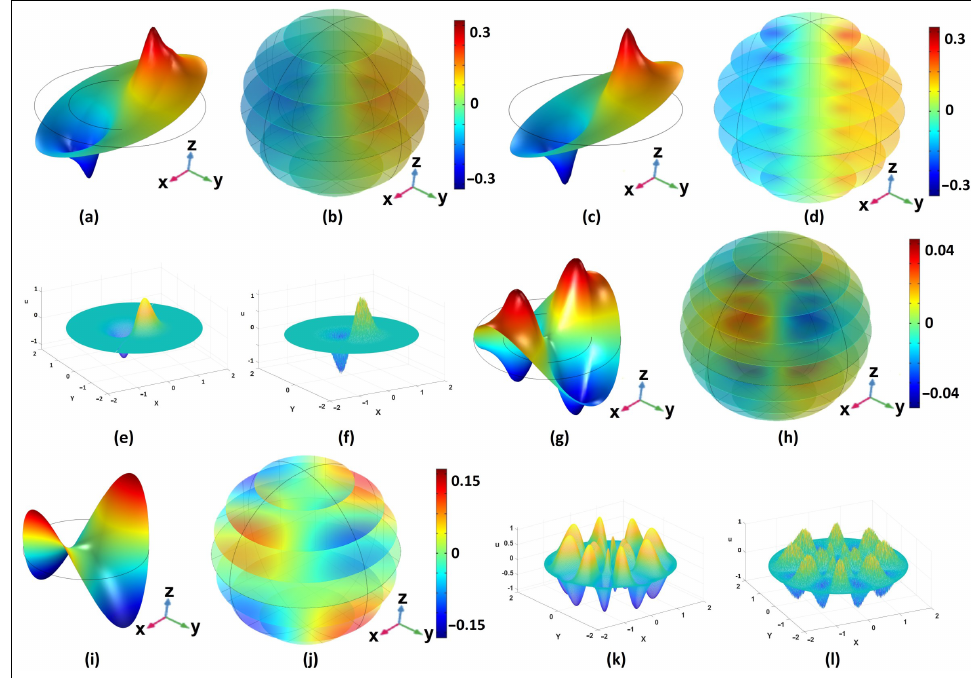
Figure 6. Solution of the problem described in Equations (21) and (22) (simplified) for the 2D and 3D case for the dipolar source and ( x 2 − y 2 ) z , as well as the original boundary problem for two regions described in Equations (4)–(8). ( a – d ) solution of the boundary problem in the dipolar source; ( a , b ) two regions case; ( c , d ) simplified 2D and 3D regions case, respectively; ( e , f ) source and recovered solution from solving the inverse problem; ( g – j ) solution of the boundary problem of the source ( x 2 − y 2 ) z ; ( g , h ) two regions case; ( i , j ) simplified 2D and 3D case, respectively; ( k , l ) source and recovered solutions from solving the inverse problem. Table 1. Software comparison. Computation times in minutes and seconds (min:sec) for the two used software: Matlab and COMSOL, obtained when solving the multiple layer conductive medium problem (original) and using our simplification proposal (reduced). We tested these methods when solving two different sources: one computed from the dipolar momentum P = [ − 1, 1] and the other one from the expression f = ( x 2 − y 2 ) z . We show the percentage error (%) and the absolute error (A) between the exact and recovered sources after solving the inverse problem in time, and dividing the time interval in 64, 128, 256, and 512 parts (each division corresponds to a moment in time). DTI (Divisions of the time interval): M (Matlab), C (Comsol)—in the last column: O (Original), R (Reduced).